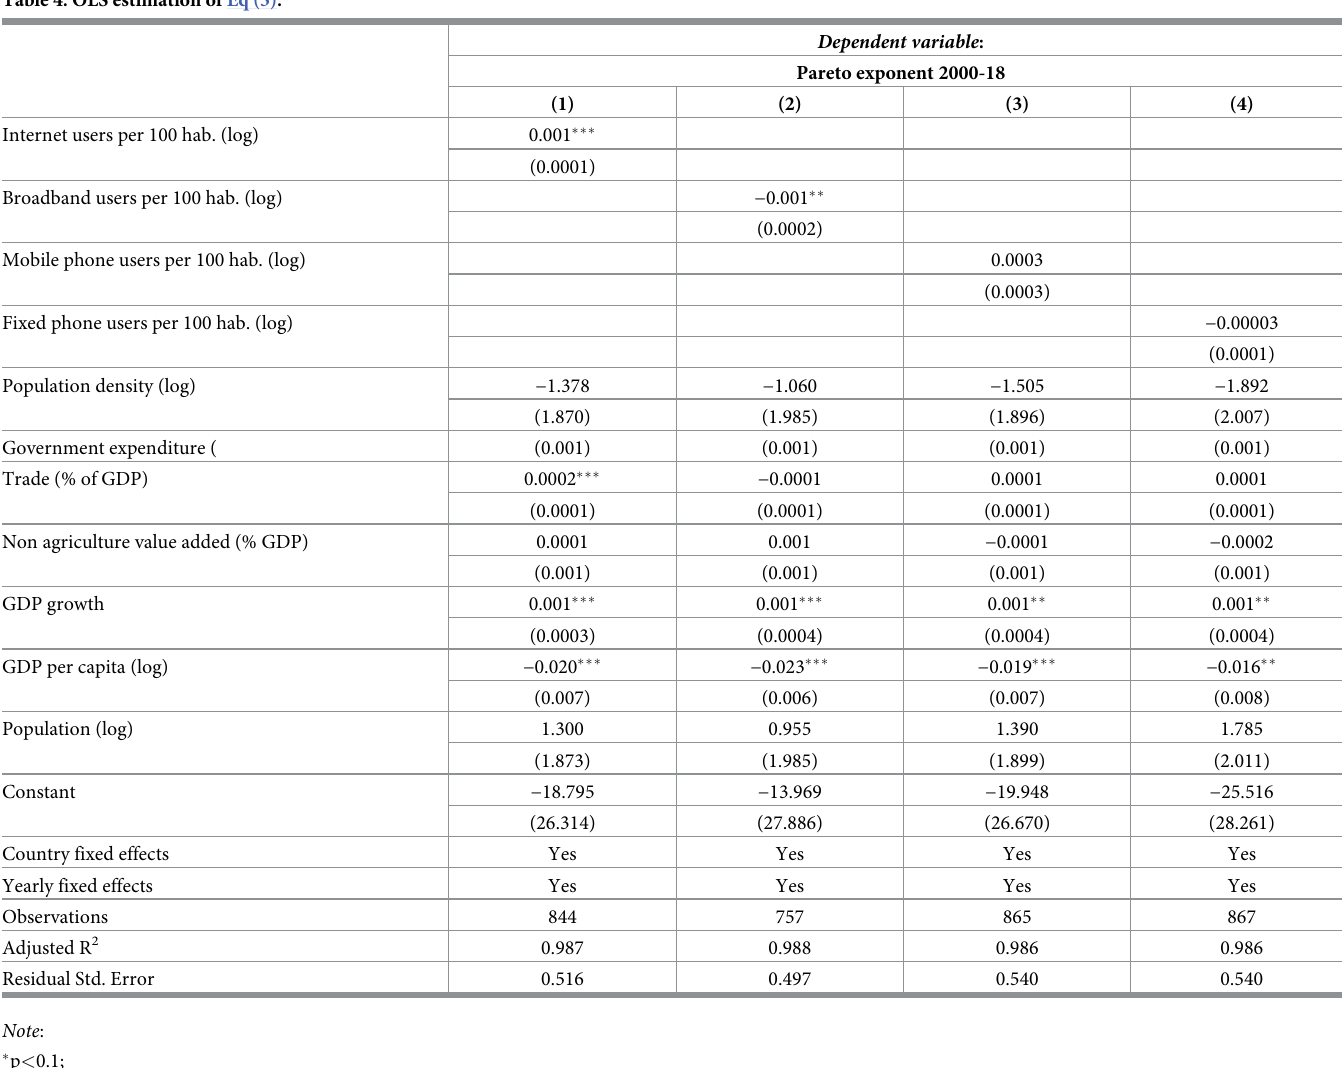
Table 4. OLS estimation of Eq